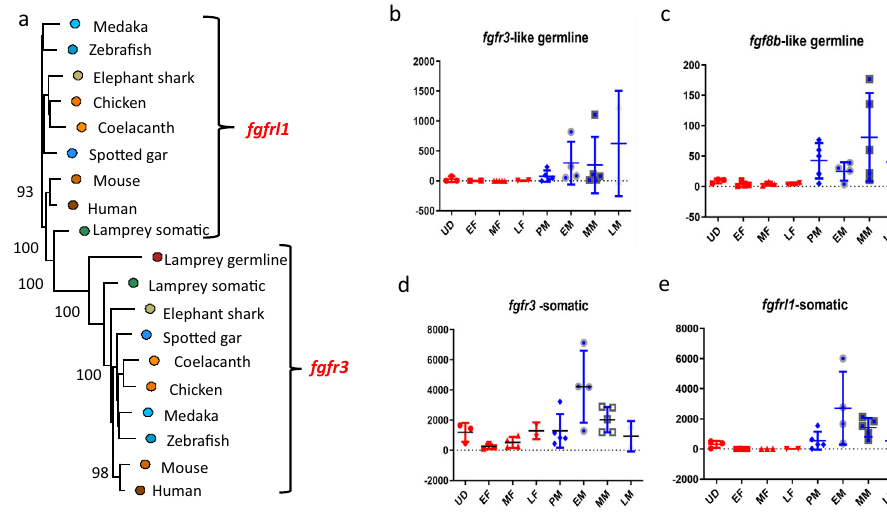
Fig. 3 Phylogenetic relationship and expression of fi broblast growth factor ( fgf ) genes. a Phylogeny of fgf receptors, fgfr1 and fgfr3 , in the sea lamprey germline and somatic genomes relative to orthologs in other vertebrates. Expression of b fgfr3 -like receptor and c putative ligand fgf8b in the germline genome and d fgfr3 and e fgfrl1 in the somatic genome. b – e The Y -axis is gene counts and the X -axis is stage, where UD is undifferentiated larvae; EF, MF, and LF are early, mid, and late females; and PM, EM, MM,Q6 and LM are prospective, early, mid, and late males, respectively.